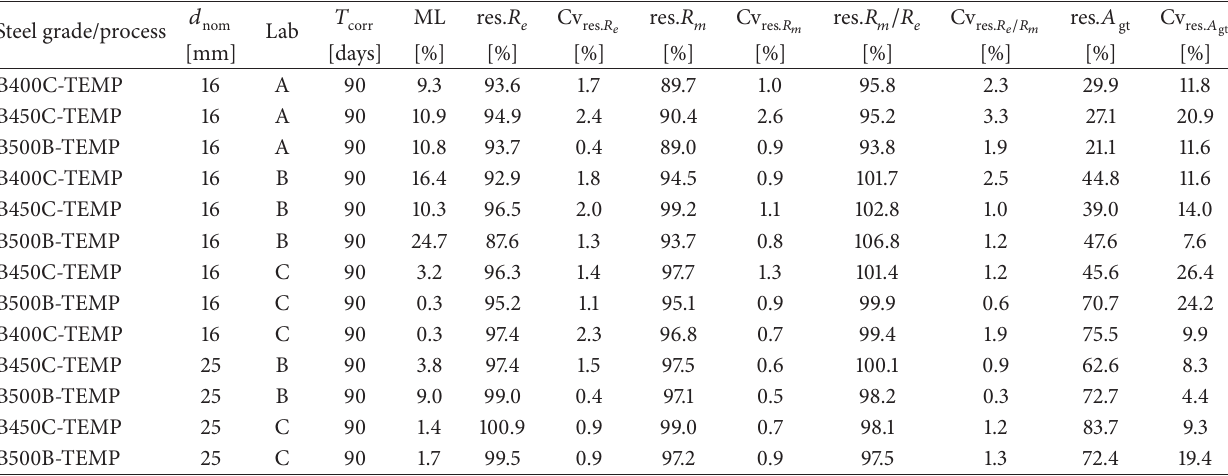
Table 3: Mean values and coefficient of variation of residual mechanical properties of corroded bars (16 and 25 mm), tensile tests.